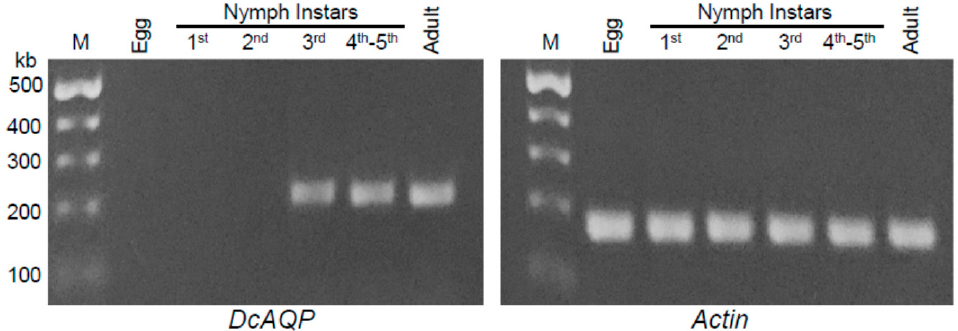
Figure 3. Transcript levels of DcAQP in different developmental stages during the life cycle of D. citri. Total RNAs were extracted using TRIzol ® Reagent from different developmental stages of D. citri including eggs and first, second, third, fourth and fifth nymphal instars and adults. After amplification, transcript levels of DcAQP were semi-quantified on a 1.5% agarose gel. Actin was used as an internal control gene.